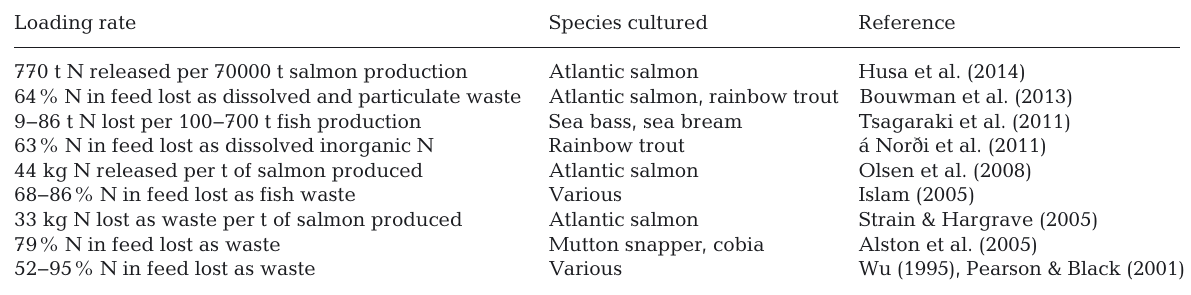
Table 1. Nitrogen (N) loading at ocean fish aquaculture sites. Values are presented in the units of the original